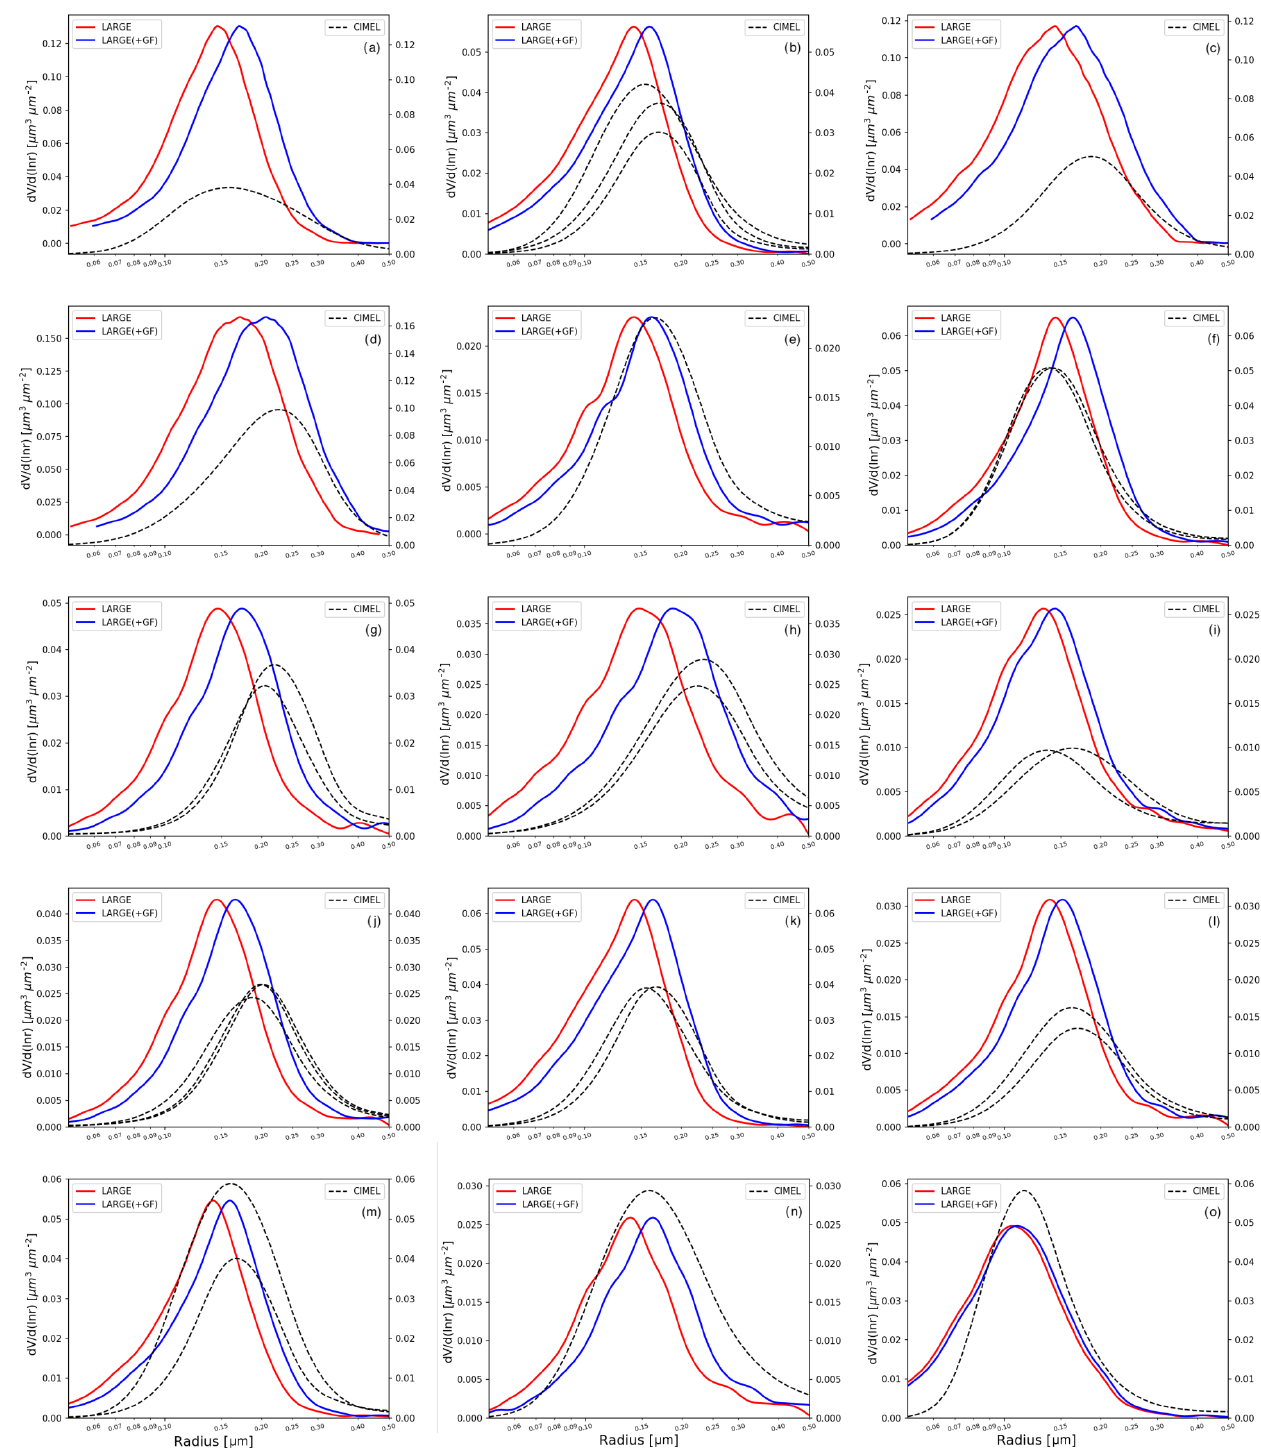
Figure 5. AERONET VSD (dashed line) comparisons with LARGE (red line) and humidified (blue line) VSDs at the data points de- fined as (a) Aldino (MD) (5 July 2011), (b) Deer_Park (TX) (13 September 2013), (c) Edgewood (MD) (5 July 2011), (d) FairHill (MD) (29 July 2011), (e) Fresno (CA) (1 February 2013), (f) Galveston (TX) (13 September 2013), (g) Hanford (CA) (1 February 2013), (h) Han- ford (CA) (4 February 2013), (i) Huron (CA) (31 January 2013), (j) Huron (CA) (1 February 2013), (k) ManvelCroix (TX) (13 September 2013), (l) Porterville (CA) (31 January 2013), (m) Smith_Point (TX) (13 September 2013), (n) Tranquility (CA) (1 February 2013) and (o) West_Houston (TX) (25 September